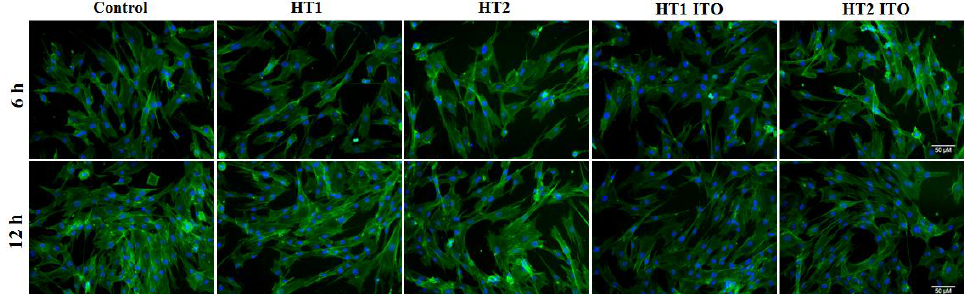
Figure 7. Actin cytoskeleton organization of dermal fibroblast cells after 6 h and 12 h of incubation with photocatalyst-treated PES samples. F-actin ( green ) was labeled with phalloidin-fluorescein isothiocyanate (FITC) and nuclei ( blue ) were counterstained with 4′,6-diamidino-2-phenylindole dihydrochloride (DAPI). Scale bar: 50 µm.